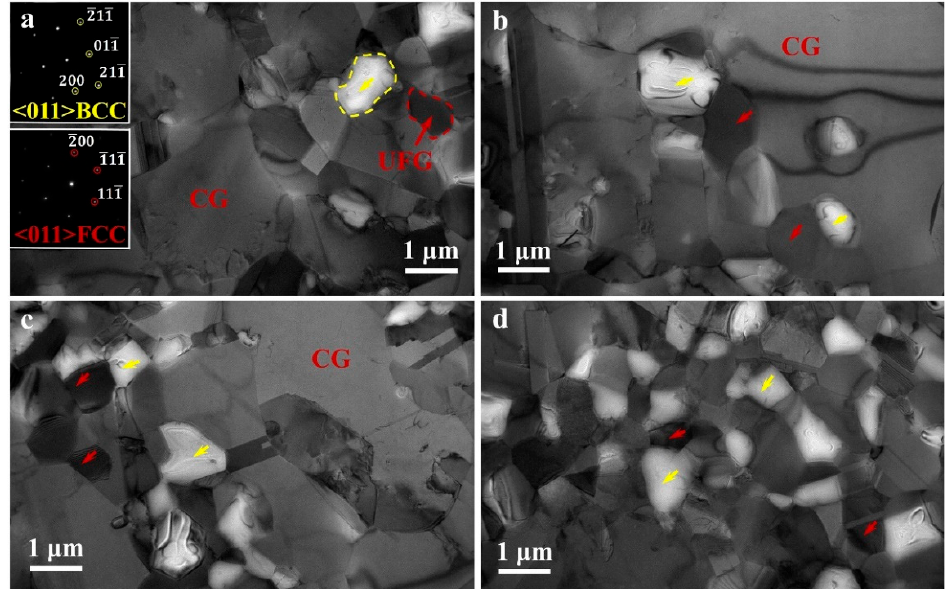
Figure 3. TEM observations for the HS 2 sample prior to tensile testing. ( a ) Both FCC and BCC phases can be observed; ( b , c ) the interiors of both FCC and BCC grains are relatively clean, indicating a low density of dislocation; ( d ) the BCC grains are distributed non-uniformly. Red arrows: the UFGs of FCC phase; yellow arrows: the UFGs of BCC phase.